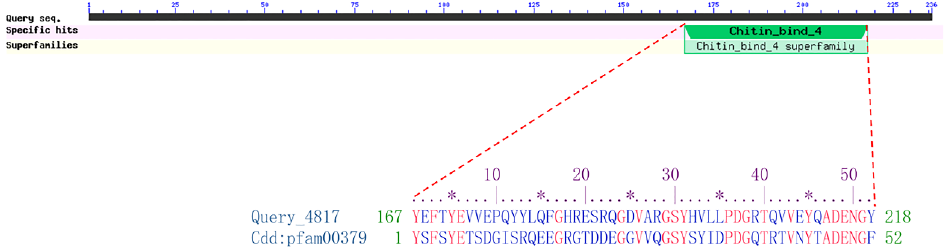
Figure 1. Conserved domain Chitin_bind_4 of Cpr21L. Alignment of Cpr21L (Query _4817) with conserved domain Cdd:pfam00379. Asterisk (*) means the 5th amino acid residue among 10 amino acid residues.